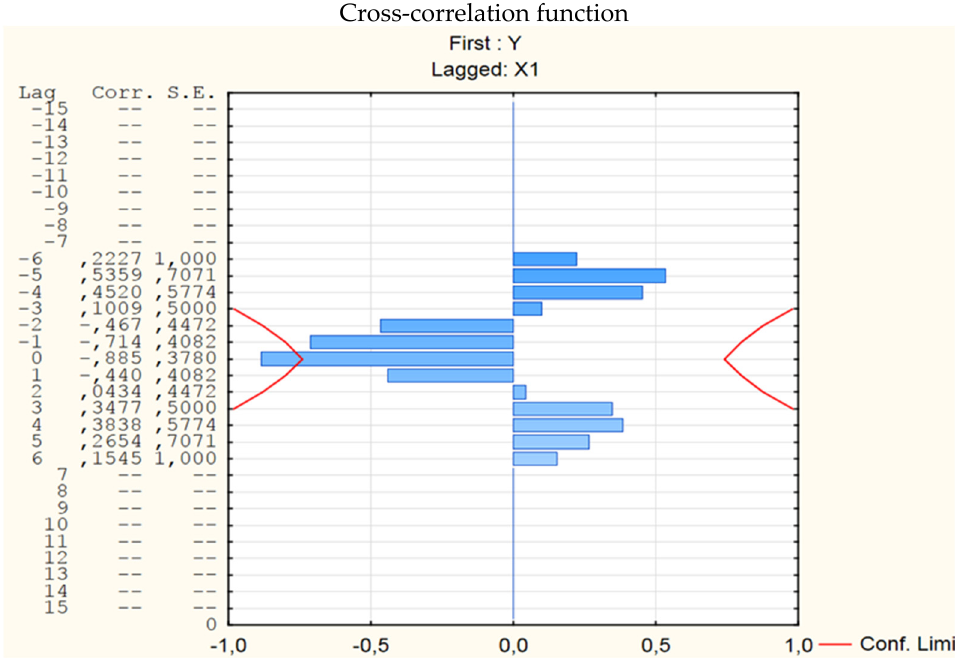
Figure 3. Cross-correlation function for GRP and GVA of the science-intensive production of the Russian Arctic zone (calculated by the authors).